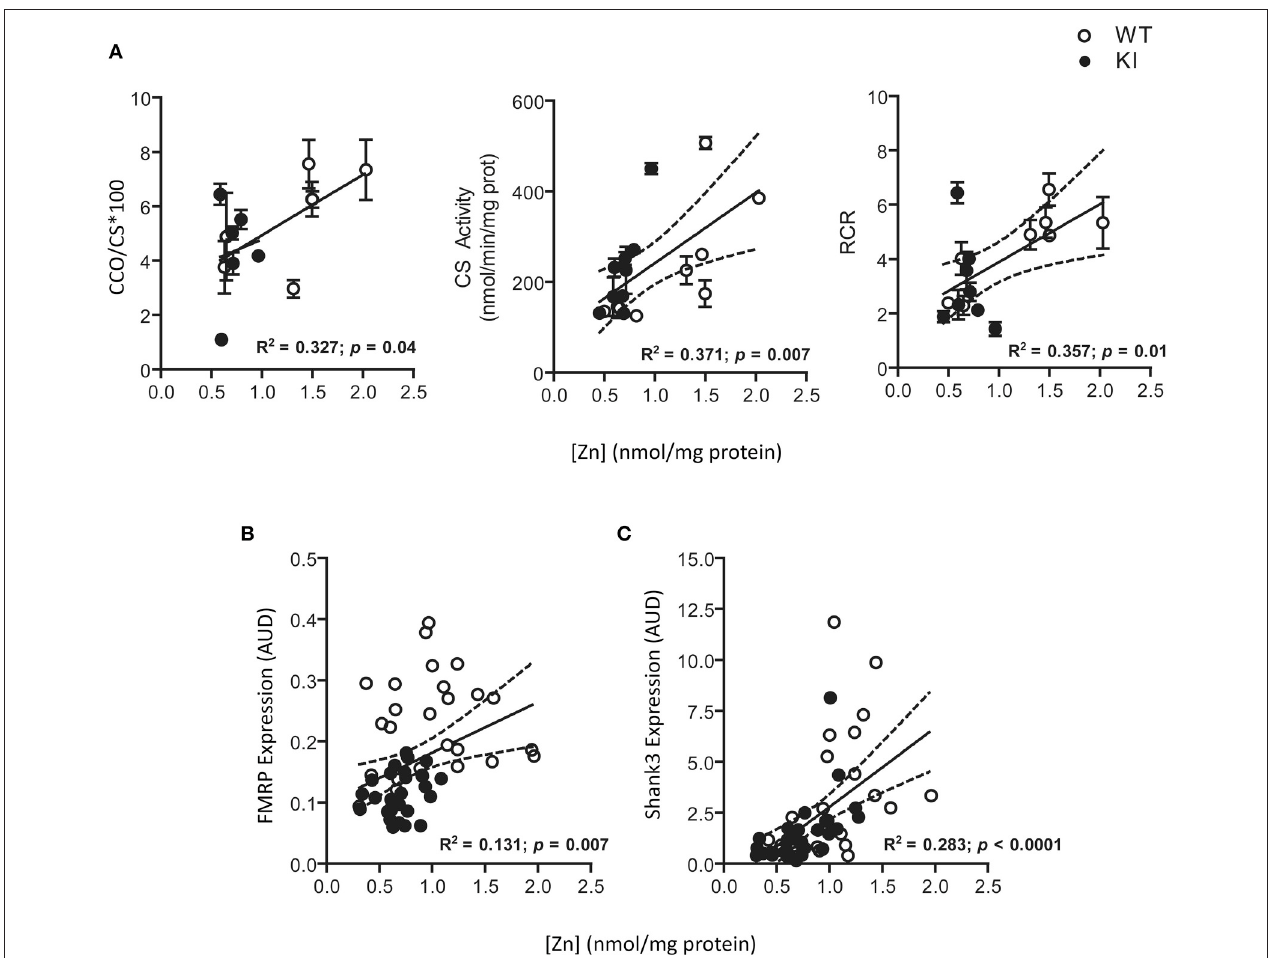
FIGURE 7 | Correlations among Zn levels, selected mitochondrial outcomes, and protein expression of FMRP and Shank3, in brain of WT and KI mice. A significant direct correlation was noted between average Zn levels and activities of CCO and CS and RCR for all the time points analyzed (A) . CCO and CS activities were expressed as nmol × (min × mg protein) − 1 . CCO activity has been normalized to citrate synthase and multiplied by 100. All the other mitochondrial outcomes did not show a correlation with Zn. A direct correlation was also observed between Zn levels and both FMRP and Shank3 protein expression (individual values) in brains of WT and KI when all time points were combined (B,C) . Dotted lines illustrate the 95% CI obtained with WT and KI